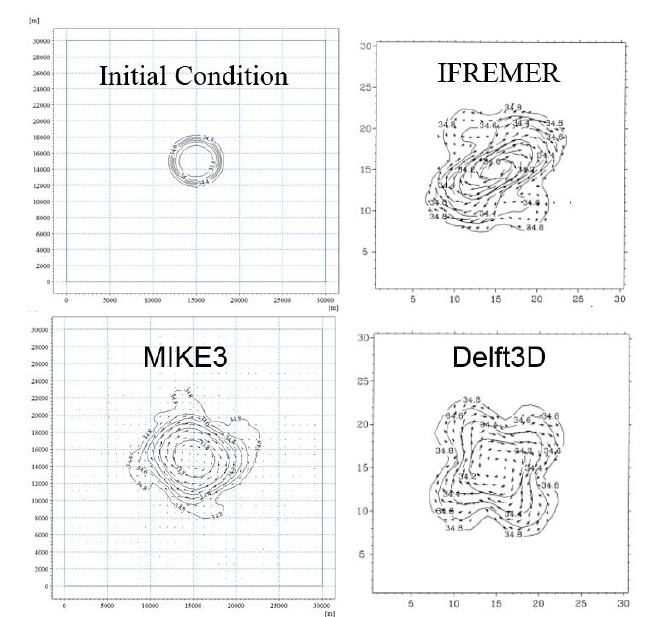
Figure5. Sea surface salinity and velocities through the center of the central eddy at the beginning and end of the experiment. Top left panel: Initial condition, Top right panel: IFREMER Model, Bottom right panel: Delft3D model, Bottom left panel: MIKE3